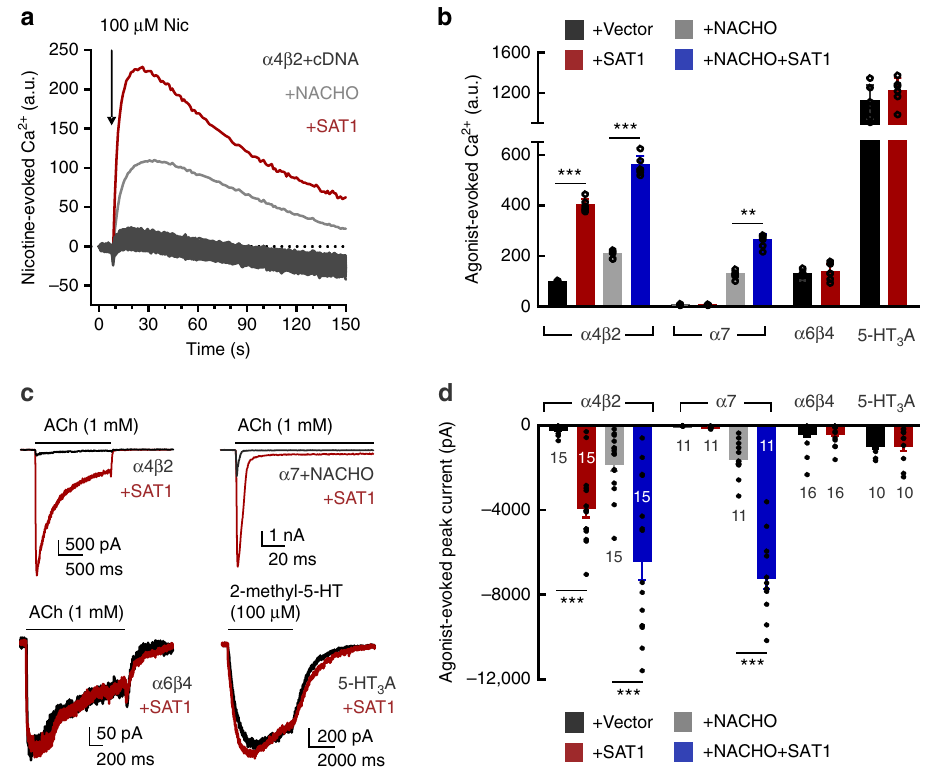
Fig. 1 High throughput cDNA screening for enhancers of α 4 β 2 function identi fi es SAT1. a HEK293T cells in 384-well plates were co-transfected with α 4-expressing and β 2-expressing plasmids along with an individual cDNA (black traces) from a human ORF collection (Broad Institute). Cells were stimulated with 100 μ M nicotine (Nic). The highest response occurred in the well containing SAT1 (red trace) and was twice the α 4 β 2 + NACHO response (gray trace), which served as positive control. b Quanti fi cation (mean ± SD) of maximum Ca 2 + signal upon agonist stimulation from HEK293T cells transfected as indicated ( n = 6). Co-transfection of SAT1 signi fi cantly enhances Ca 2 + signal in α 4 β 2 ( p < 1e − 4 ), α 4 β 2 + NACHO ( p < 1e − 4 ) and α 7 + NACHO ( p = 0.002) cells. For all α 6 β 4 conditions, cells were co-transfected with plasmids encoding accessories BARP and SULT2B1 13 . c Representative whole-cell current responses elicited from HEK cells co-transfected with GFP and cDNAs as indicated. d Summary graphs of agonist- evoked peak currents (mean ± SEM) from HEK293T cells transfected with indicated cDNA combinations. Similar to maximum Ca 2 + signal,